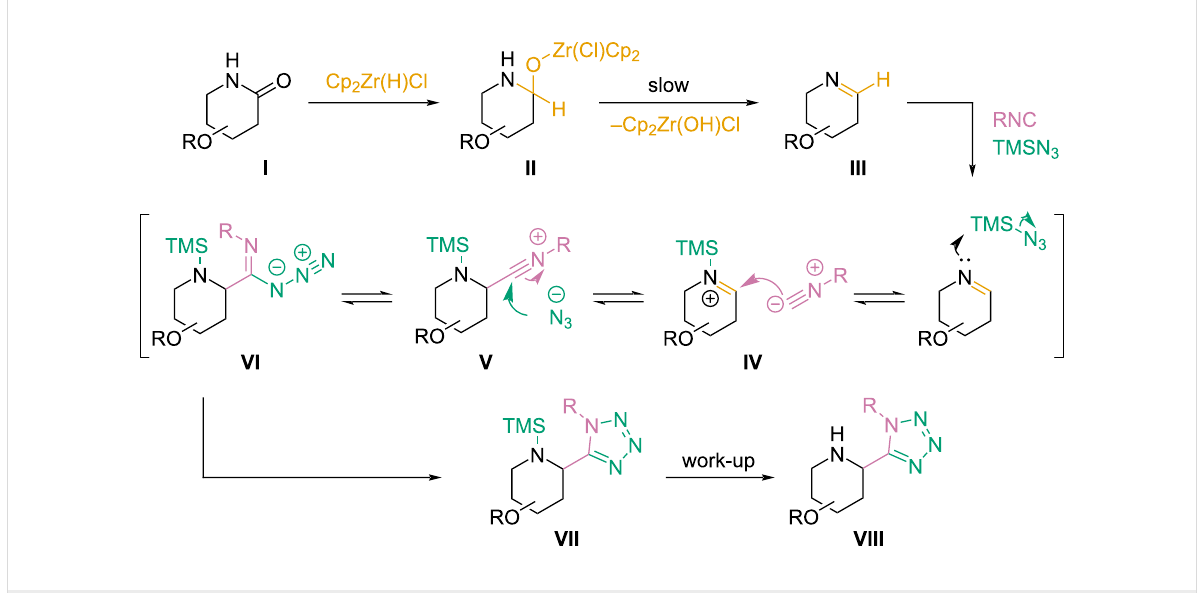
Scheme 7: Proposed reaction mechanism for the described Ugi–azide reaction variant.